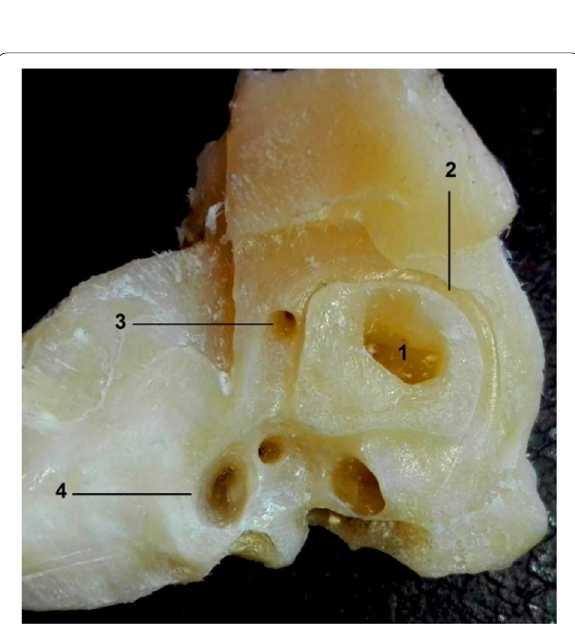
Fig. 10 A sagittal section in the semicircular canal parallels the anterior semicircular canal. 1. Subarcuate fossa, 2. Anterior semicircular canal, 3. Posterior semicircular canal, 4. Lateral semicircular